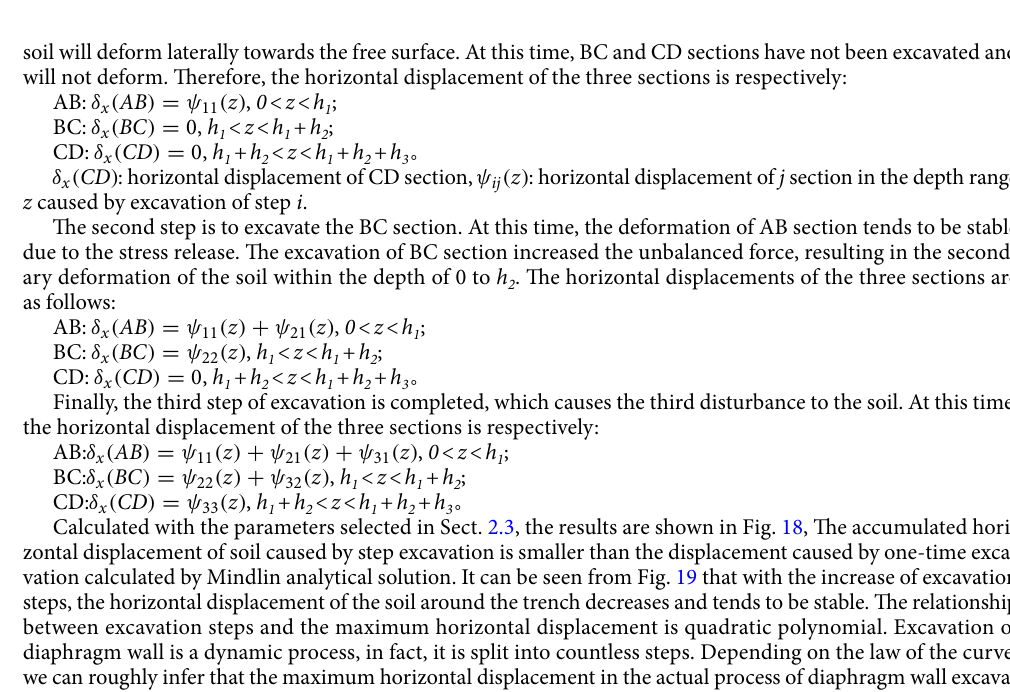
Figure 18. Comparison of horizontal displacement of step-by-step excavation and one-time